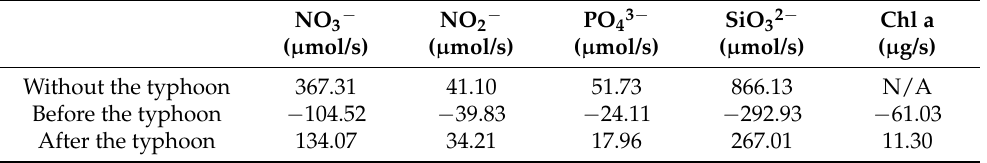
NO 3 − NO 2 − PO 43 − SiO 32 − Chl a ( µ mol/s) ( µ mol/s) ( µ mol/s) ( µ mol/s) ( µ g/s)